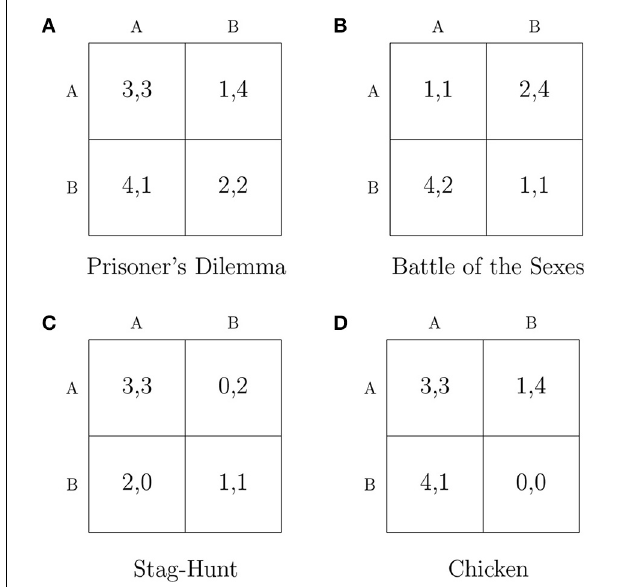
FIGURE 1 | Payoff